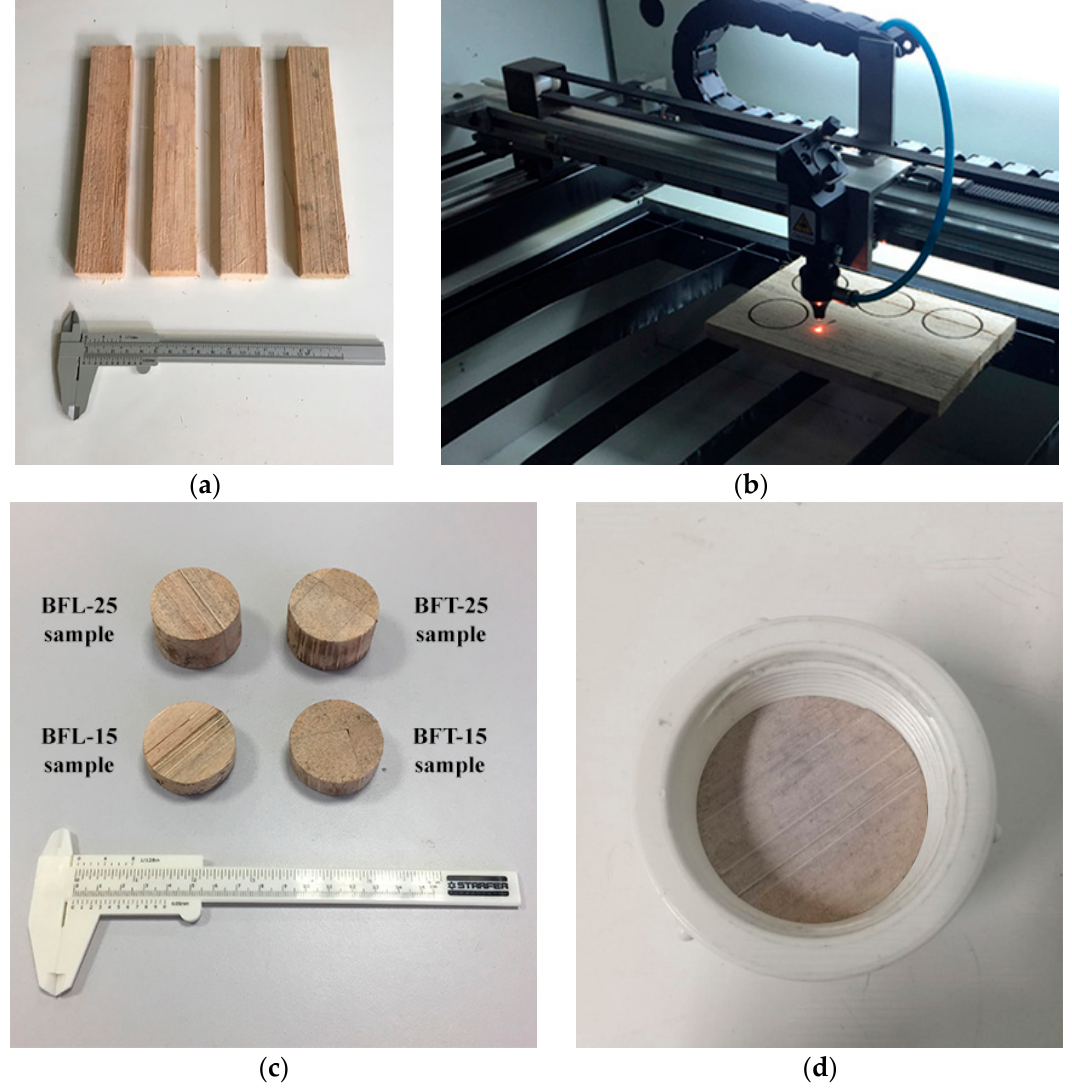
Figure 6. Buriti foam samples for the sound absorption test: ( a ) layers of Buriti foam for boards production, ( b ) laser cutting of the samples, ( c ) longitudinal and transverse configurations of the Buriti foam samples, and ( d ) Buriti foam sample inside the sample holder of the impedance tube.